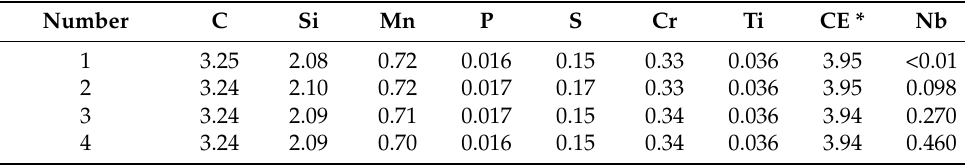
Table 1. The chemical composition of the samples after smelting (% by mass).